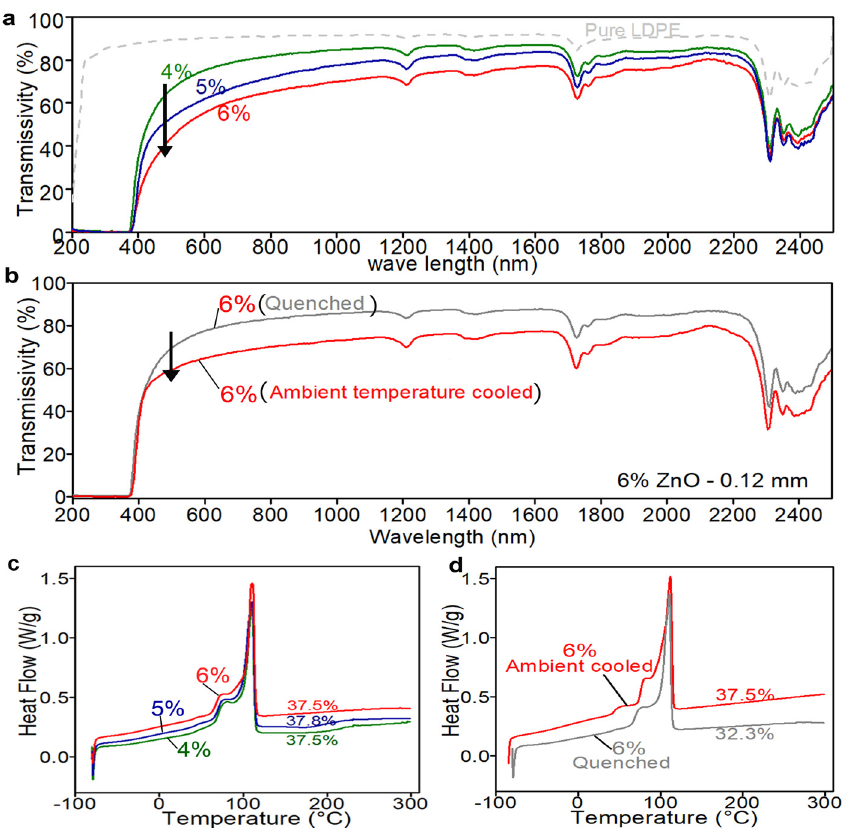
Figure 5: The factors a ff ecting the transmissivity of passive cooling fi lm. ( a ) E ff ect of the nanoparticle concentration, ( b ) e ff ect of the curing process, ( c ) the DSC curves of fi lms with di ff erent particle concentrations, and ( d ) the DSC curves of the quenched and ambient temperature - cooled